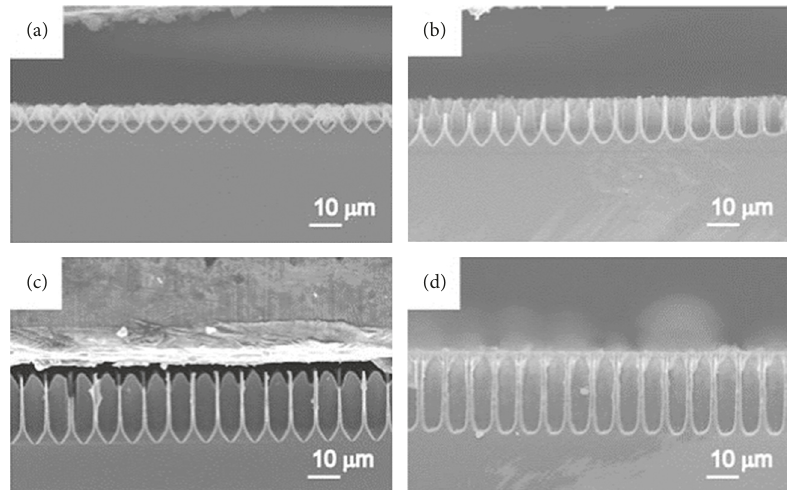
Figure 7: SEM micrographs of macropores formed in HF solutions containing various types of alcohol. Cross-sectional views of silicon anodized in a 10–20 Ω cm prepatterned p-type silicon at 14mA · cm − 2 for 1h in HF solutions containing (a) MeOH, (b) EtOH, (c) PrOH, and (d) BuOH [58] under the terms of the creative commons CC BY